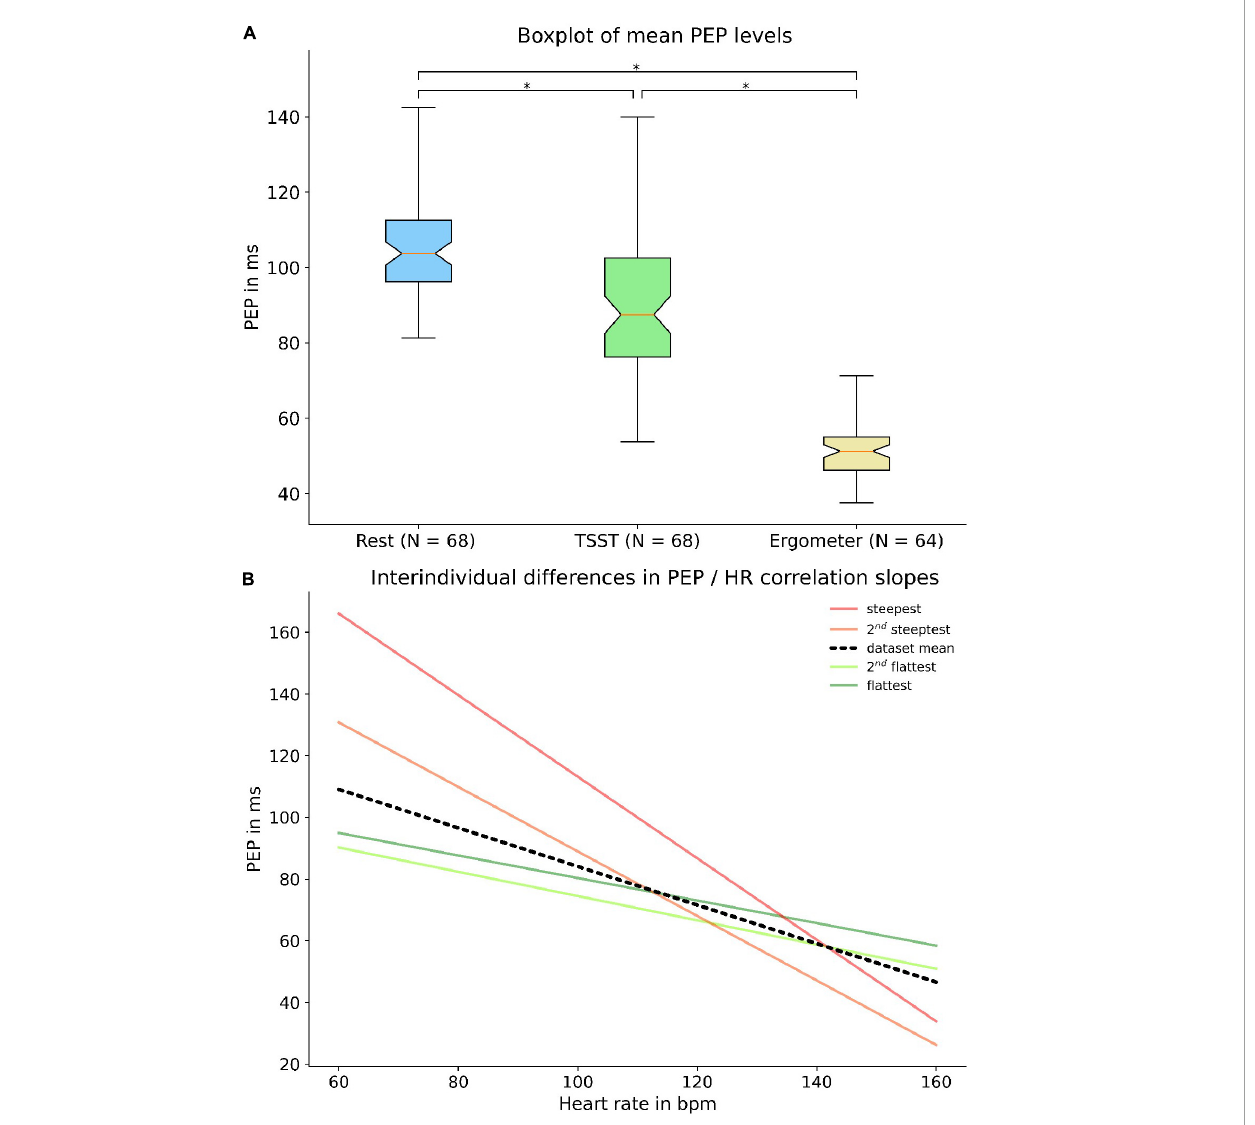
FIGURE8 Interindividual variance of PEP: The upper panel shows a boxplot (A) of individual subject PEP values at rest, at the first question of TSST and the last step of bike ergometer treading. Broad quartiles and long whiskers symbolize a large interindividual variability. The lower panel shows interindividual differences in regression slopes (B) between heart rate and PEP. The black line indicates the dataset mean while the green and red lines represent the flattest and steepest slopes, respectively. ∗ = p <